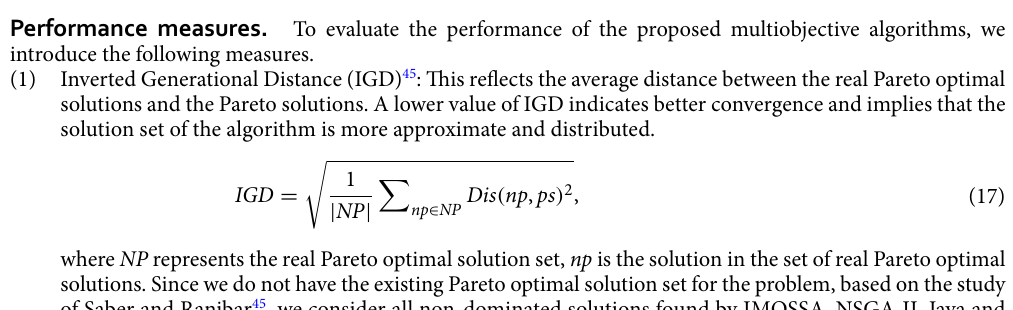
Algorithm parameter setting. The parameter configuration can impact the performance of the algo- rithm in solving the GFJSP. The proposed IMOSSA contains three important parameters. The proportion of pro- ducers PP , the proportion of sparrows aware of danger PD , and the safety threshold ST . The Taguchi approach of Design of Experiment (DOE) 44 is used at different scales to obtain the optimal combinations of parameters. Each parameter has three levels, PP ∈ {0.5, 0.7, 0.8}, PD ∈ {0.1, 0.2, 0.3} and ST ∈ {0.5, 0.65, 0.8}. Additionally, to reduce the quantity of experiments, Taguchi’s orthogonal experiment method is adopted. Because three parameters, PP , PD , and ST, need to be tested, according to Taguchi’s orthogonal array L9(3 3 ), there are a total of 9 groups of experiments, and each experiment is repeated 30 times. The other parameters in the experiment are consistent with those in Table 4. For a multiobjective GFJSP, the degree of Pareto optimality is used as the response factor, which indicates the percentage of nondominated solutions obtained by the cur- rent experiment that are not dominated by the solutions obtained by the other 8 groups of experiments. The experimental results for different combinations of parameters are analyzed by Minitab. The final parameter set- tings of IMOSSA are displayed in Table 5 for the small, medium, and large cases. The optimal combinations of parameters are PP = 0.5, PD = 0.1, and ST = 0.5 for the small-scale problems; PP = 0.5, PD = 0.1, and ST = 0.5 for the medium-scale problems; and PP = 0.5, PD = 0.3, and ST = 0.65 for the large-scale problems. As the Jaya algorithm does not require parameterization, the above DOE method is used to test the parameters of NSGA-II and find the optimal ones. There are two important parameters of NSGA-II, including the crossover probability CP and mutation probability MP , where CP ∈ {0.5, 0.55, 0.6} and MP ∈ {0.1, 0.15, 0.2}. The optimal combinations of parameters for different problem scales are represented in Table 6.